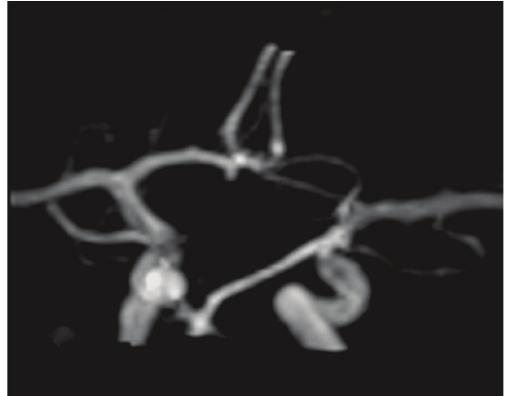
Figure 2: 3D TOF MRA at the level of the circle of Willis performed at 3 T with application of MT and FS clearly shows a very small (2mm) aneurysm at the A1 segment. This finding was confirmed with the